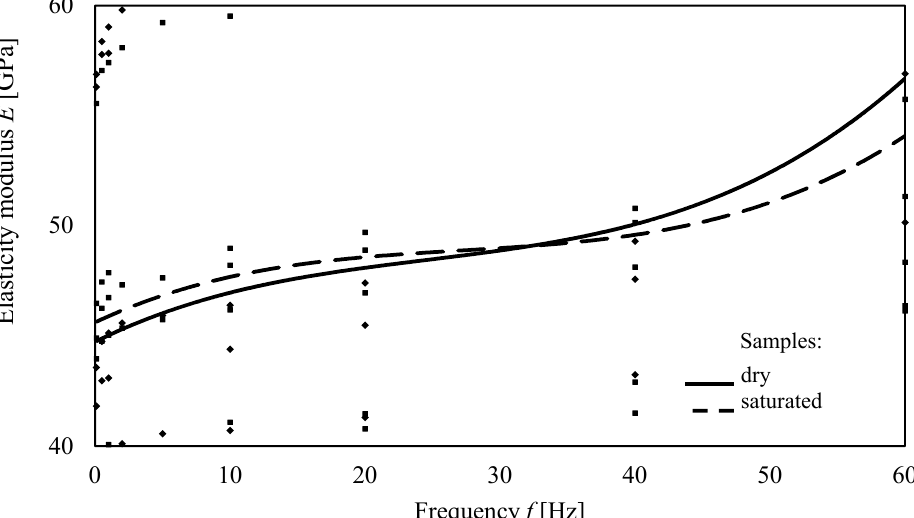
Figure 17. Dynamic modulus of elasticity of dry and saturated limestone (data averaged over 6 samples shown in Figures 15 and 16) depending on the frequency of the applied dynamic load.